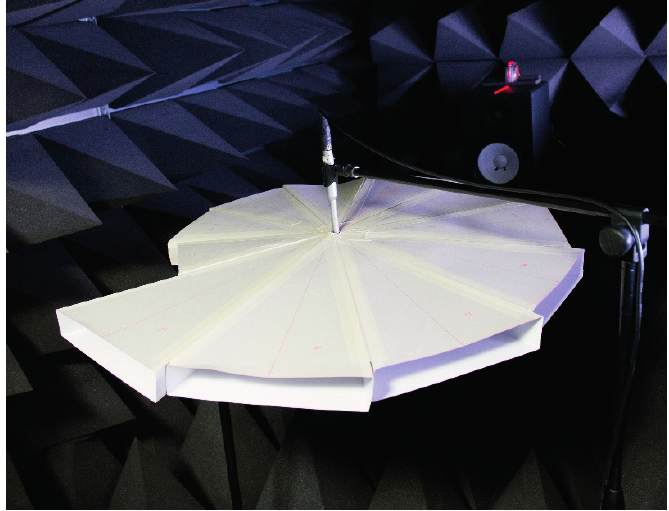
Figure 8. Acoustic experiment with ML